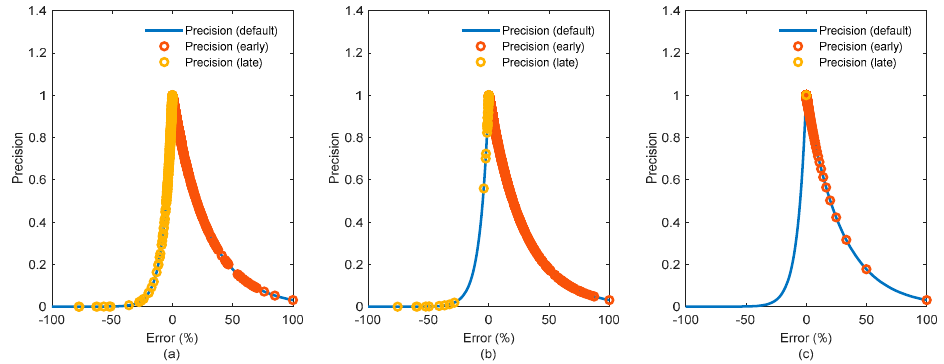
Figure 2. Example of distributing RUL/HI predictions under different precision levels: ( a ) bad predictions. Predictions are far from the center. Early and late predictions are equally distributed; ( b ) acceptable predictions. The model is even more precise than in ( a ). It is an early predictor because late predictions are almost neglected; ( c ) good predictions. More precision is provided in this case. More concentration towards the center and less dispersion toward early and late predictions.